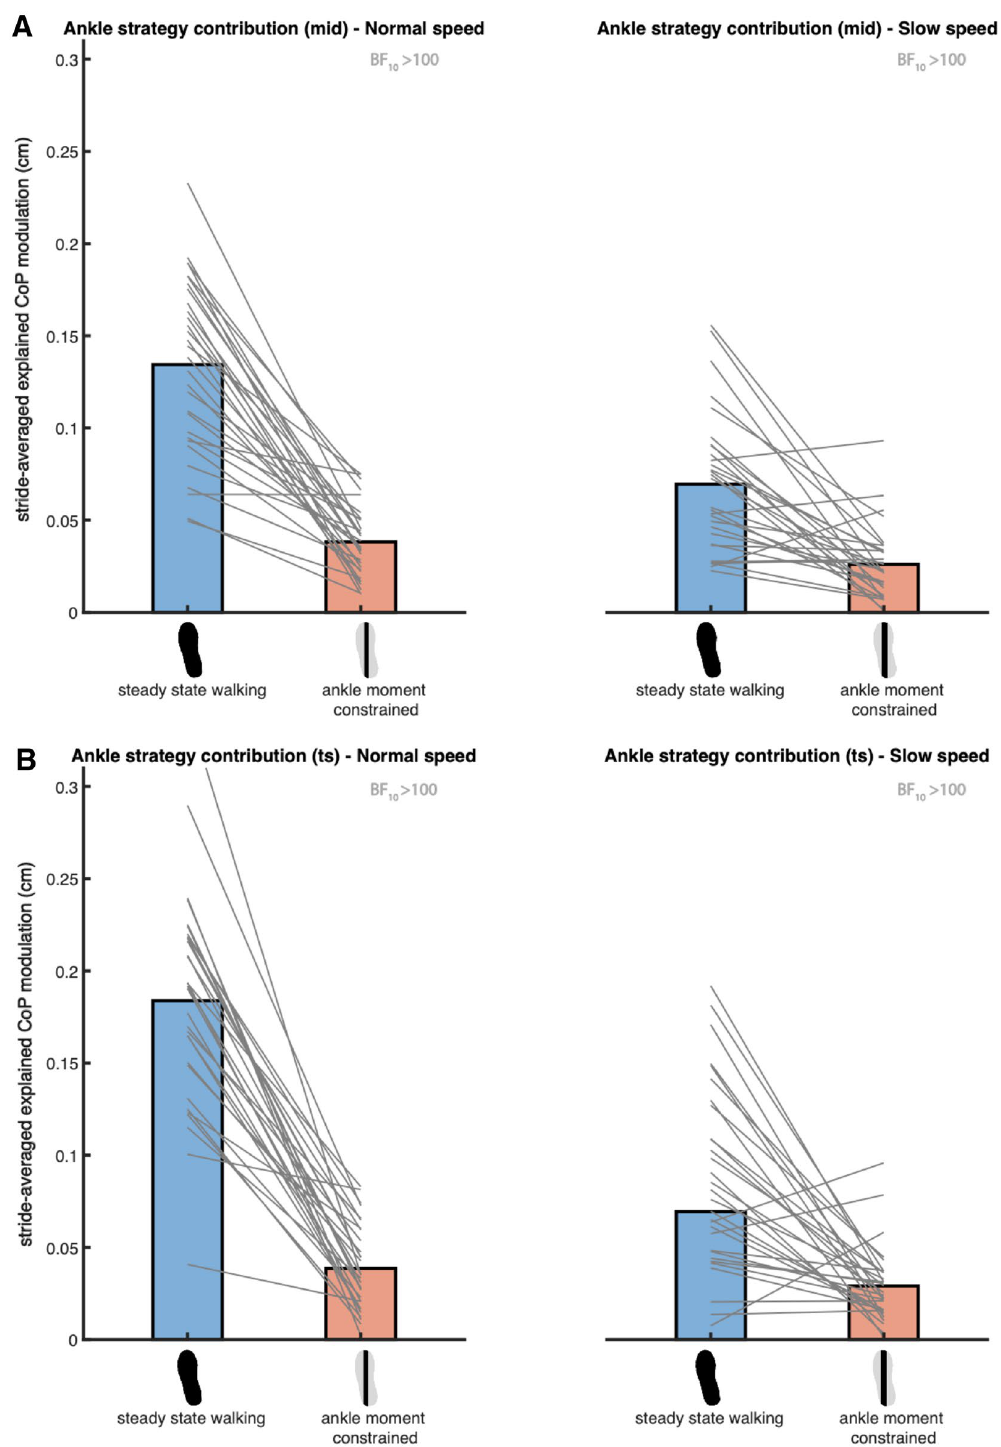
Figure 6. Mean absolute explained variance of the ankle strategy model (2). For normal (left) and slow (right) walking speeds panels A and B depict respectively the absolute explained variances for the foot placement error at mid- and terminal swing. Blue and red bars represent the steady-state walking and ankle moment constrained conditions respectively. In this figure the absolute explained variance is expressed as the square root of the stride averaged explained variance, as a reflection of the magnitude of the average explained CoP shift in centimeters. The grey lines connect individual data points. The Bayes factors (BF 10 ) denote the degree of evidence for a decreased absolute explained variance in the ankle moment constrained condition, as compared to steady-state walking. This figure was created using Matlab 2021a (https:// www. mathw orks. com/ produ cts/ matlab. html) and Adobe Illustrator CC 2018 (https:// www. adobe. com/ nl/ produ cts/ illus trator.